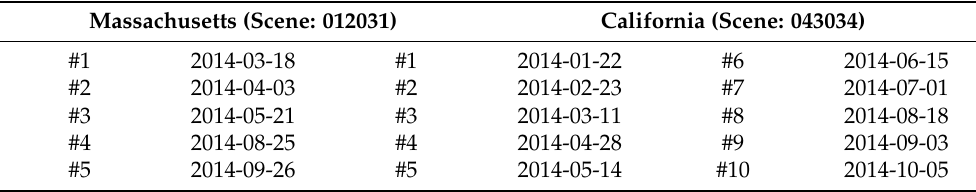
Table 2. Acquisition of Landsat-8 imagery for time-series super-resolution